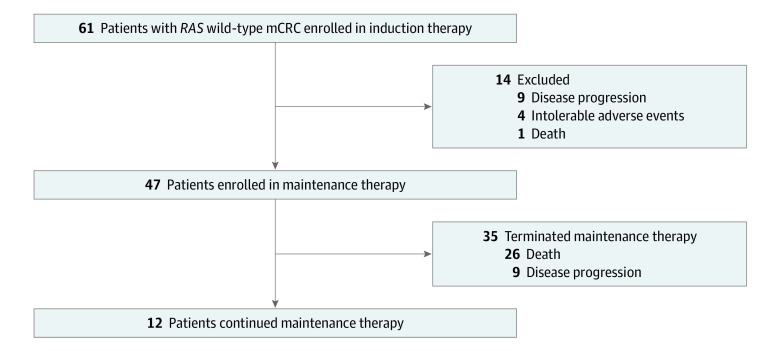
Patient EnrollmentmCRC indicates metastatic colorectal cancer.